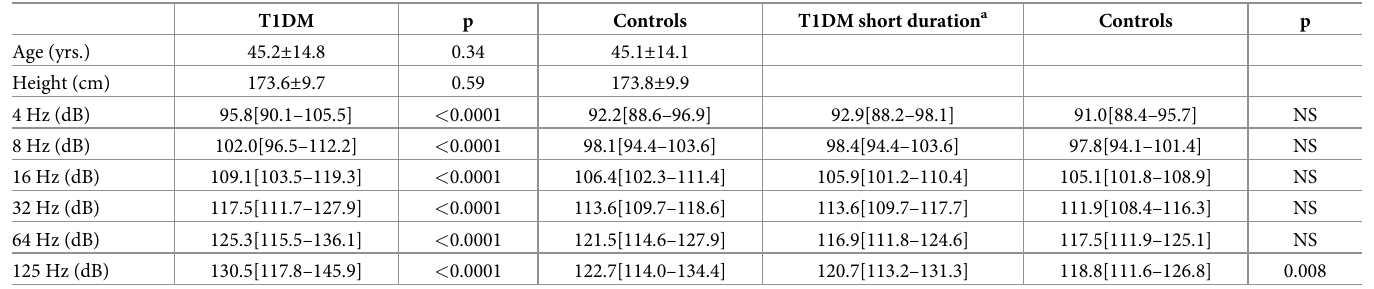
Table 3. Comparison between patients and non-diabetic controls matched for age and